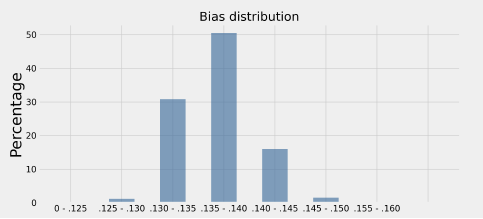
Figure 3: Bias Distribution for Chosen IV approach for ID ∆ (0)